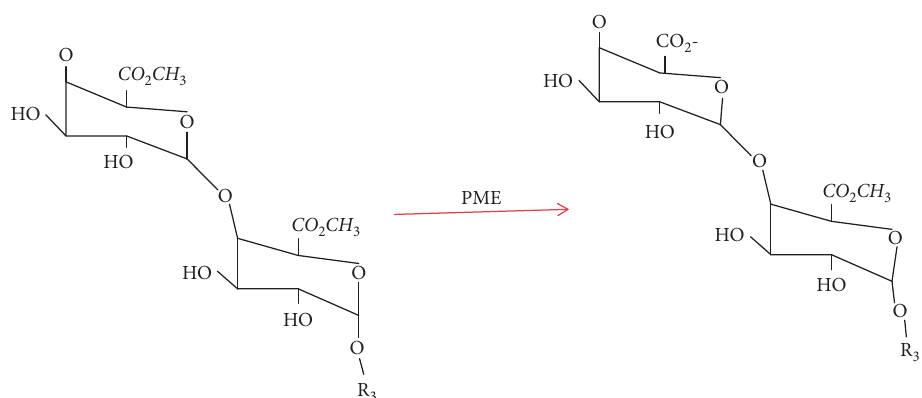
Figure 2: Action of Pectin methylesterase on polygalacturonic acid chain [13].